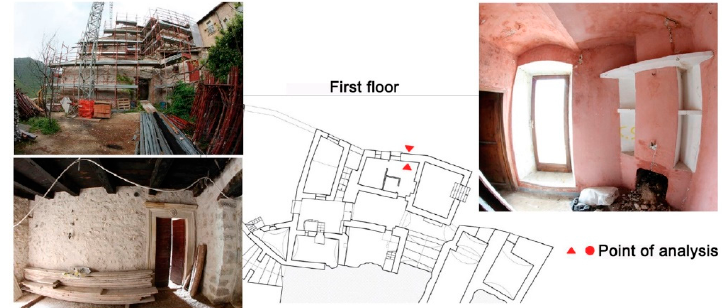
Figure 3. Point where the measurement was performed.